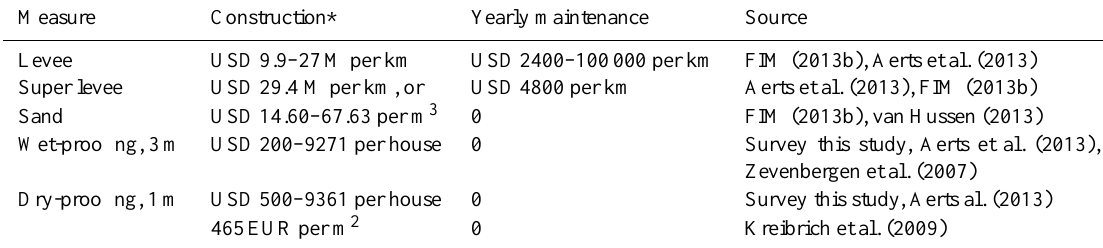
Figure 5. Modelled inundation depths for different return periods for two sea-level scenarios. The top figures ( A , B , and C ) result from using the baseline sea-level scenario, and the bottom figures ( D , E , and F ) result from using the sea-level rise scenario. Table 2. Costs for different adaptive measures per